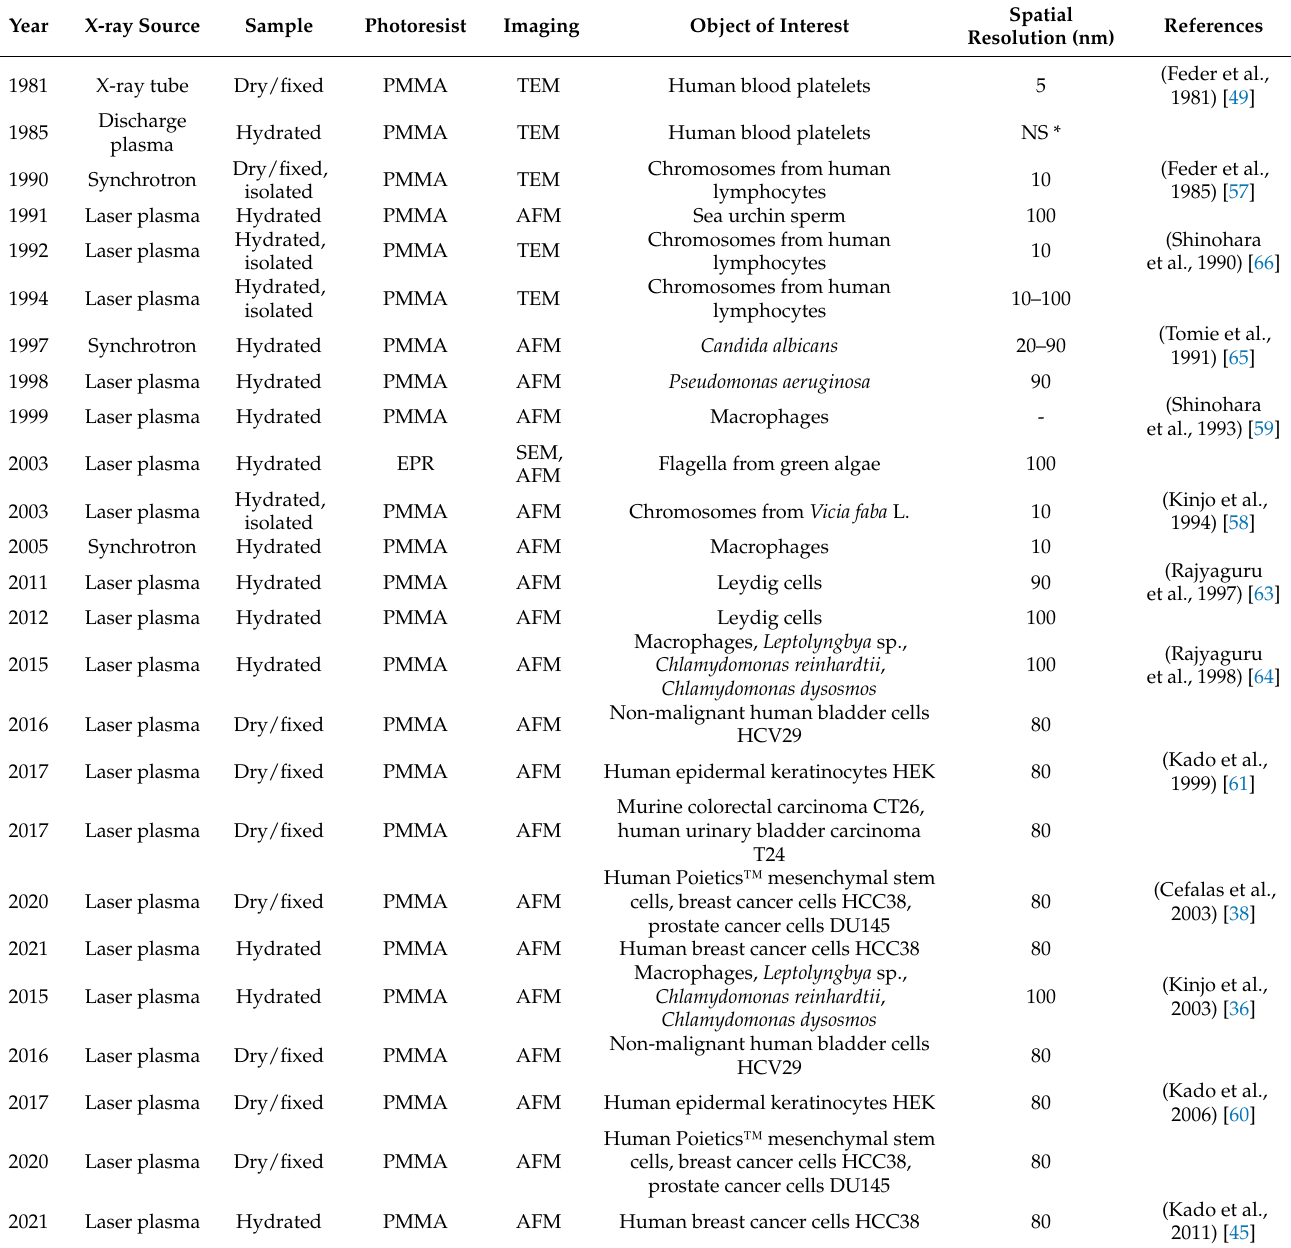
Table 1. Major biological application of soft X-ray contact